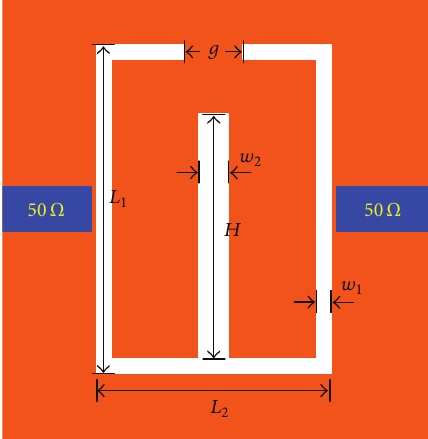
Figure 1: Structure of proposed DSLR unit.